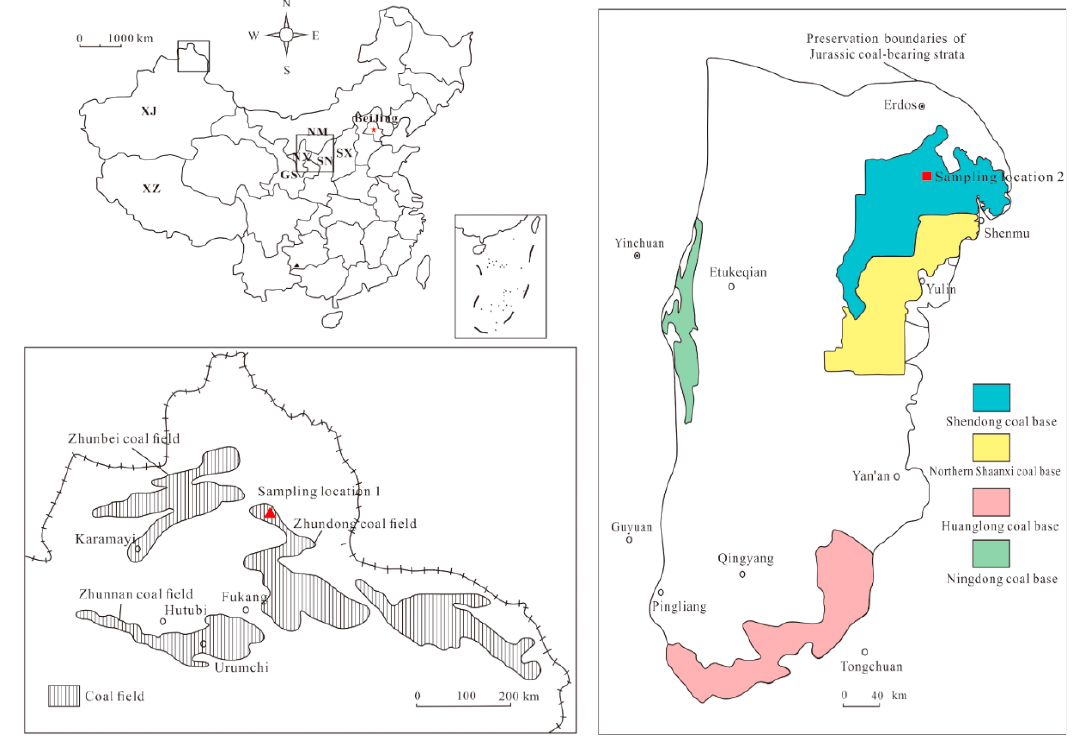
Figure 1. Locations of the Yihua and Daliuta Mines in China.